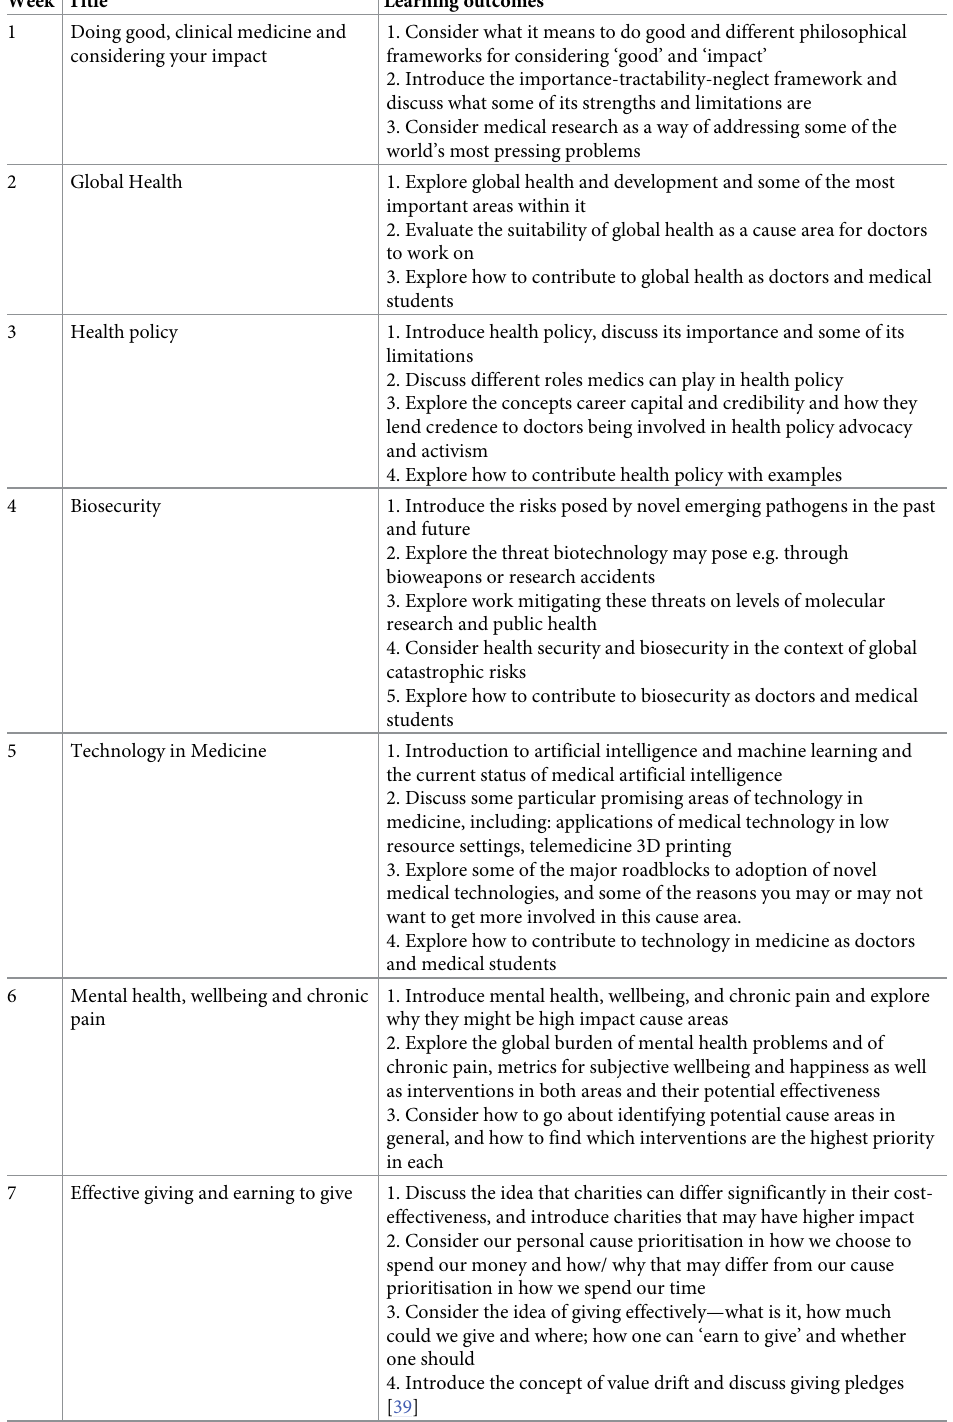
Table 1. Themes and summarised learning objectives of each week of the